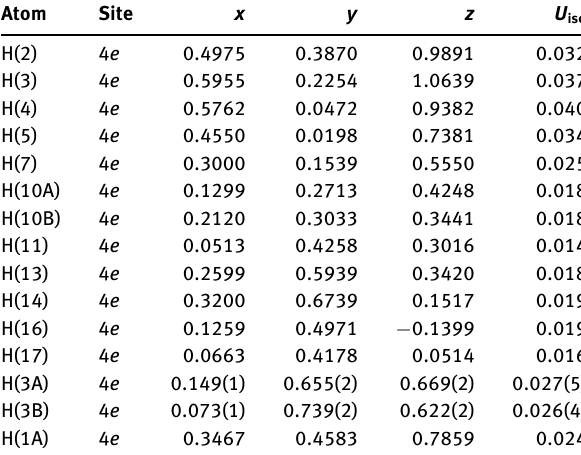
Table 2: Fractional atomic coordinates and isotropic or